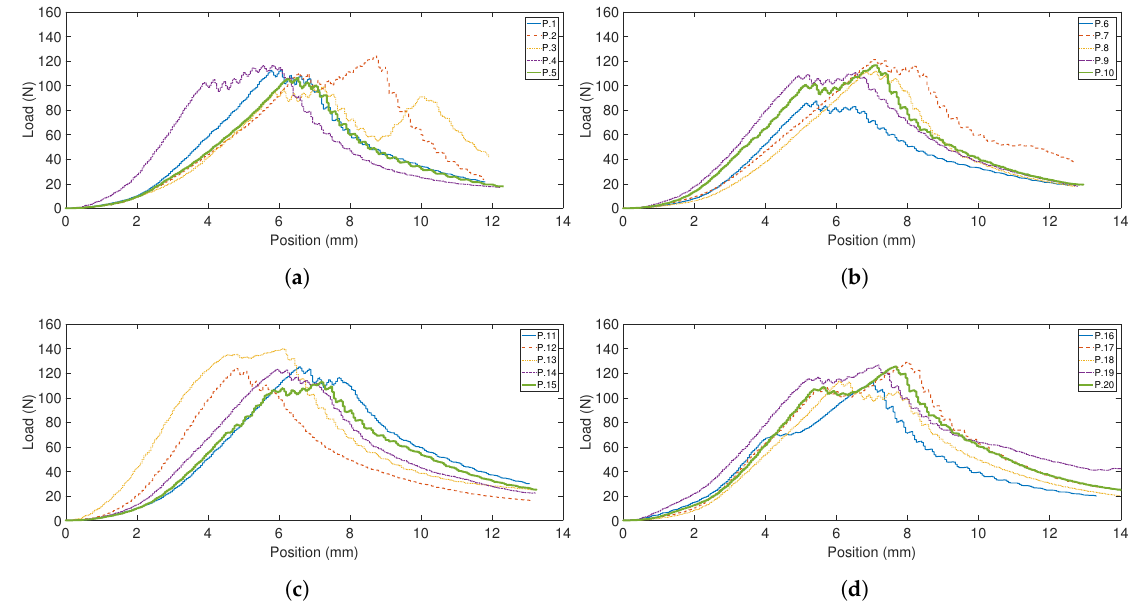
Figure 12. Position-load for a straight blade. Graphs are ordered from lower to higher diameter sizes and P indicates the sample number. ( a ) First quarter of peduncles tested . Sample diameters ranging from 9.82 to 10.34 mm. ( b ) Second quarter of peduncles tested. Sample diameters ranging from 10.58 to 10.96 mm. ( c ) Third quarter of peduncles tested. Sample diameters ranging from 11.07 to 11.27 mm. ( d ) Fourth quarter of peduncles tested. Sample diameters ranging from 11.35 to 12.05